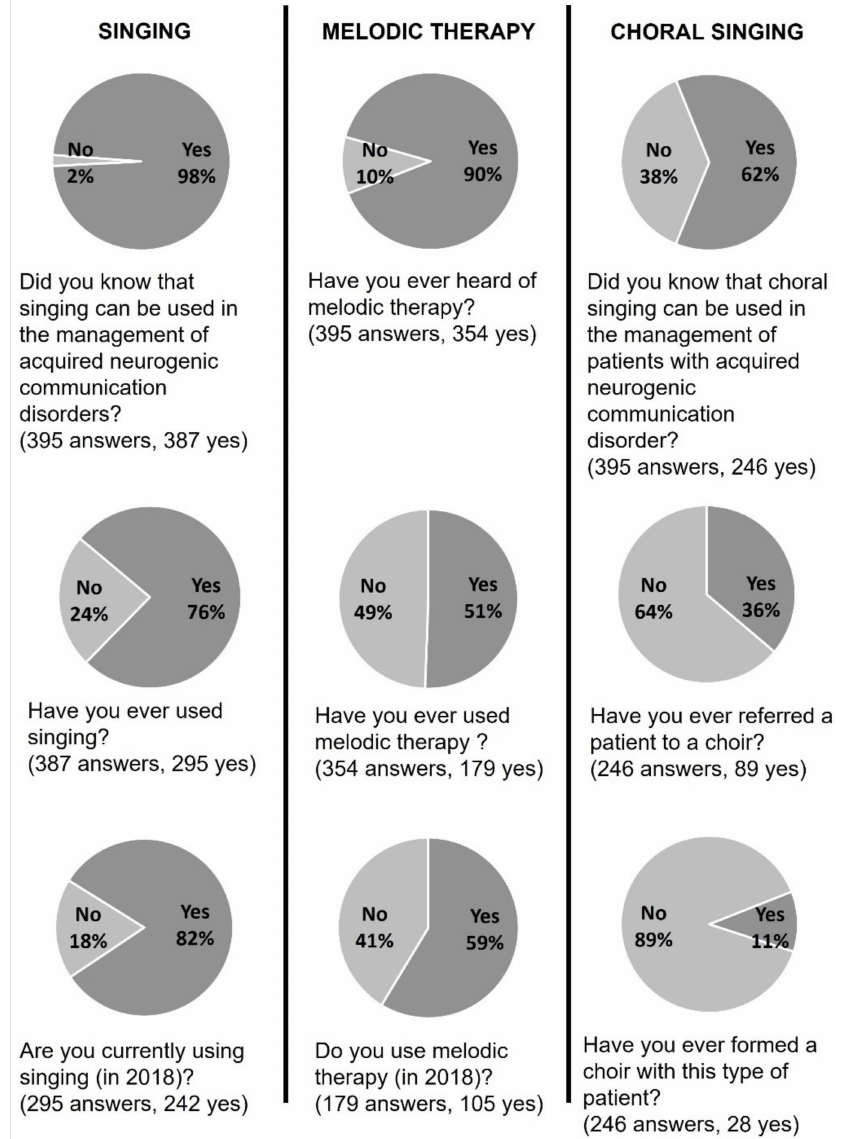
Figure 1. Answers to the closed questions of the questionnaire in the Singing, Melodic Therapy, and Choral Singing